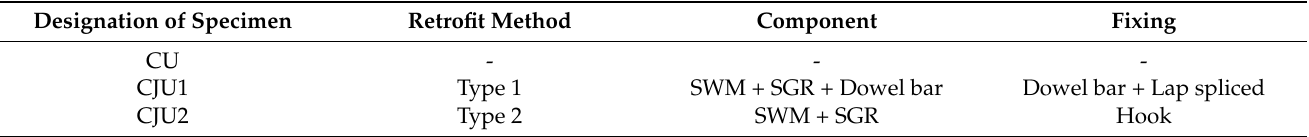
Table 1. Comparison of reinforcement details between specimens.